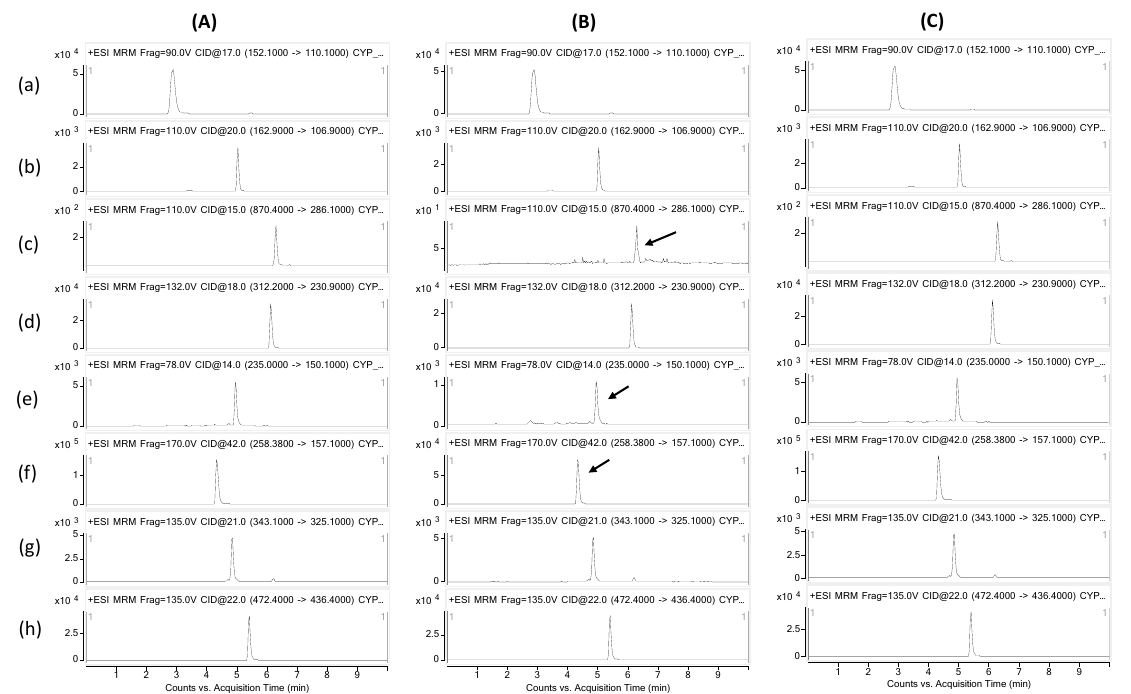
Figure 1. Representative multiple reaction monitoring (MRM) chromatograms of human liver microsome samples of, ( A ) control; ( B ) H. helix extract-treated, and ( C ) Hederacoside C (HDC)-treated. A fraction of human liver microsomal was incubated with the substrate mixture, in an NADPH-generating system, and H. helix extract (2.5 mg/mL) or HDC (100 µM) for 30 min and the cytochromes P450 (CYP)-specific metabolite formation was determined by LC-MS/MS. (a) Acetaminophen; (b) 7-OH coumarin; (c) 6-OH-paclitaxel (d) 4-OH-diclofenac; (e) 4-OH-mephenytoin; (f) dextrorphan; (g) 1-OH-madazolam; and (h) terfenadine (IS).